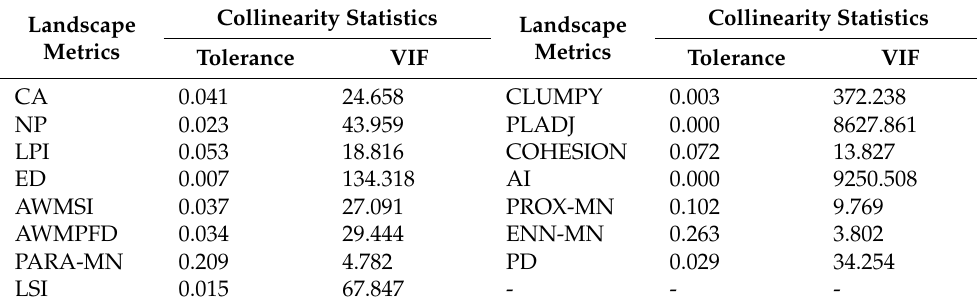
Table 1. Multicollinearity test results